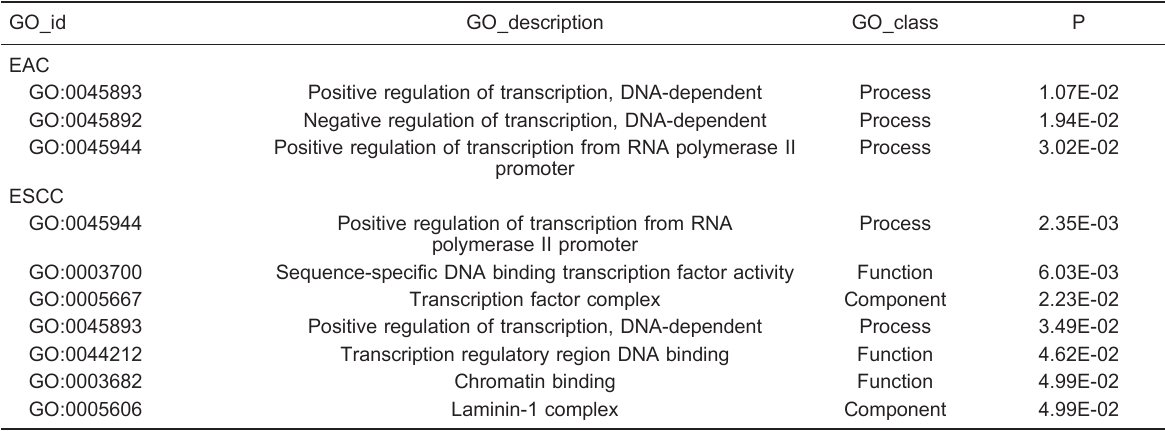
Table 3. Gene ontology (GO) enrichment analysis for the differentially expressed target genes of selected miRNAs in esophageal adenocarcinoma (EAC) and squamous-cell carcinoma